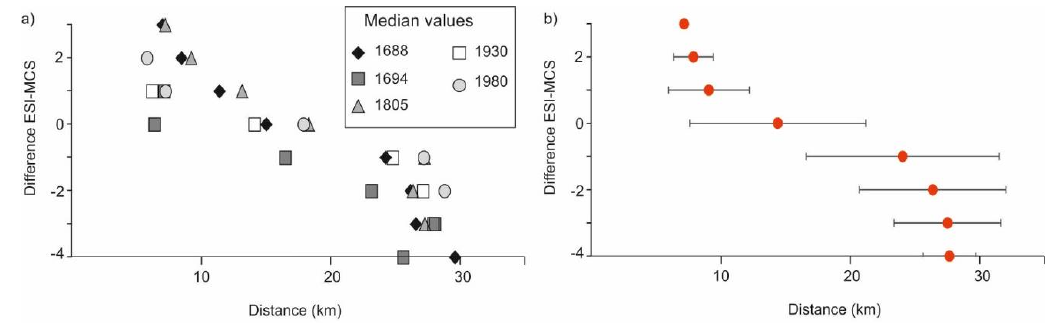
Figure 9. ( a ) Median values of the ESI-MCS field as a function of epicentral distance for each of the five historical earthquakes; ( b ) boxplots showing the mean value and standard deviation of the data shown in panel ( a ).